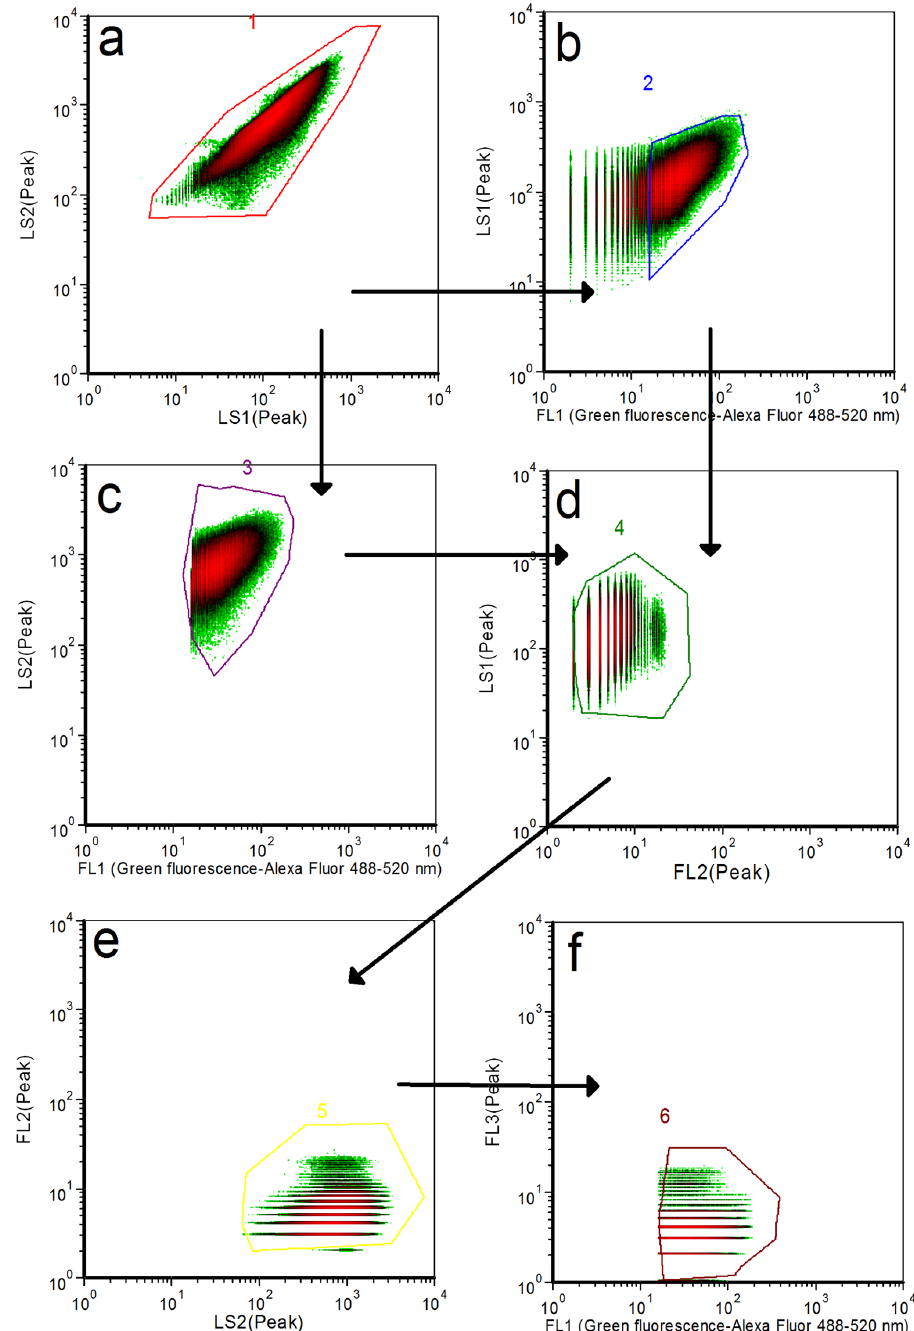
Fig 2. Flow cytometer analysis of E . coli O157 through serial gates. Signal information from the scatter plot (a) pass through a combination of scatter and fluorescence (b, c, d and e) to the final fluorescence plot (f). Gate logic is indicated by